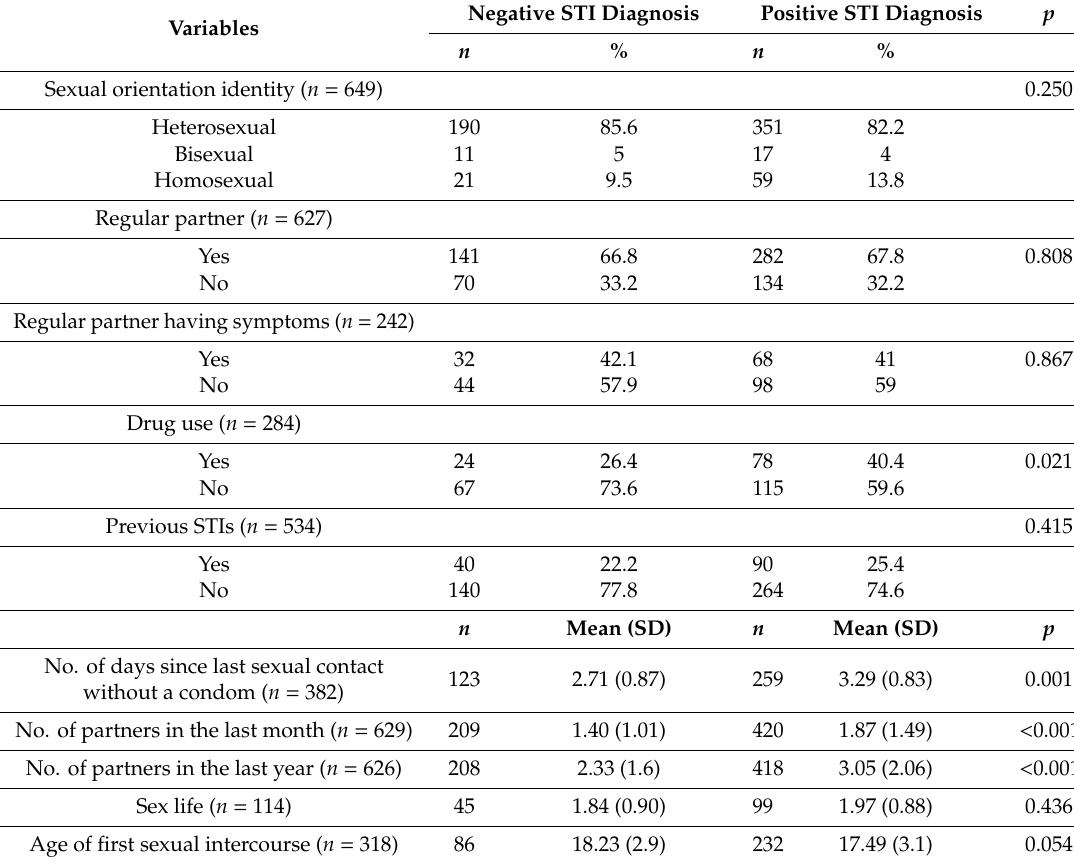
Table 3. STI diagnosis vs. risk indicators.